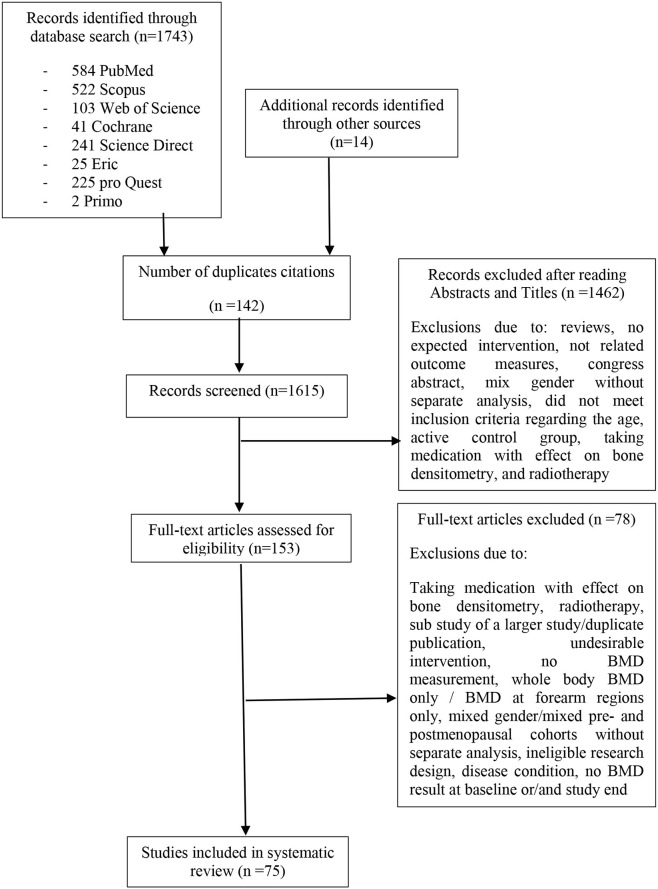
Flow diagram of search process.